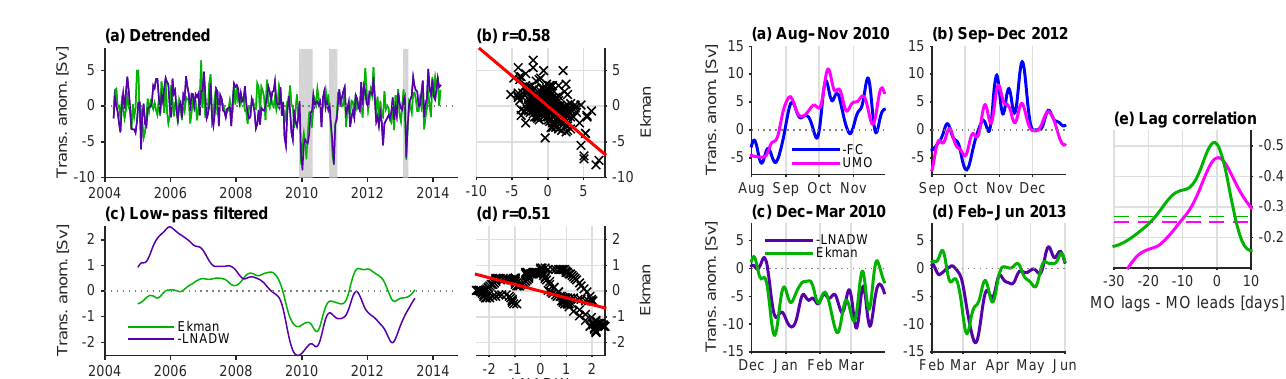
Figure 6. As Fig. 5 but for the Ekman and − LNADW transport anomaly time series.